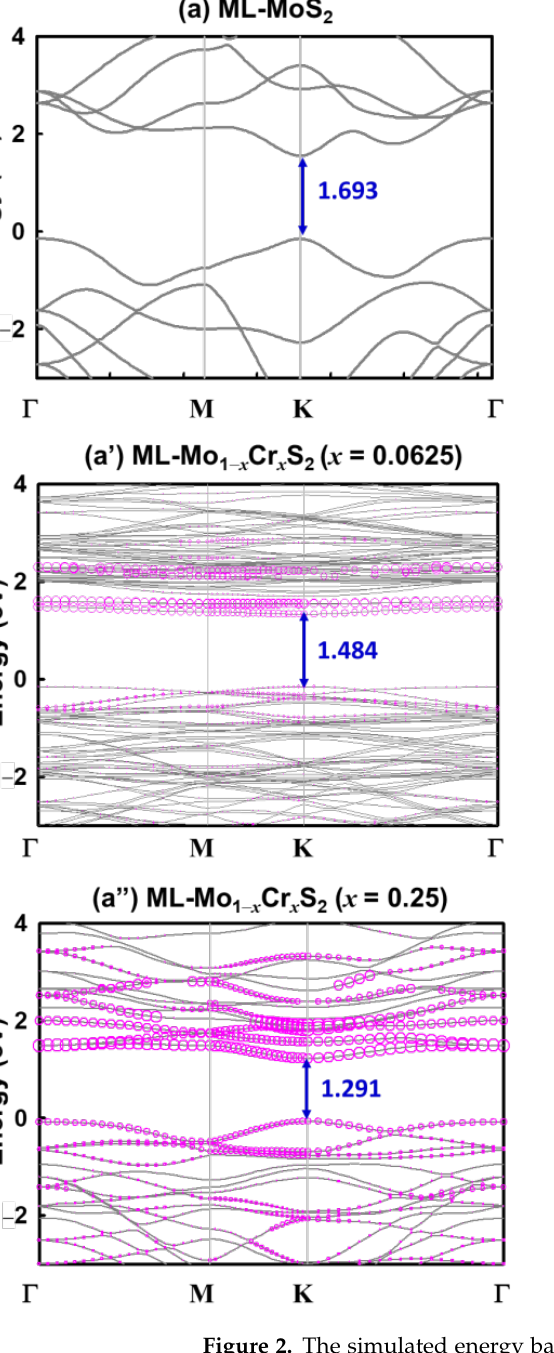
Figure 2. The simulated energy bands of ( a ) ML-MoS 2 and ( b ) ML-WS 2 . ( a (cid:48) , a (cid:48)(cid:48) ) ML-Mo 1 − x Cr x S 2 and ( b (cid:48) , b (cid:48)(cid:48) ) W 1 − x Cr x S 2 materials with respect to different mole fractions. The zero energy was set to the valence band maximum. The black lines and purple circles are all bands and projected bands contributed by the Cr element, respectively. The circle sizes of the projected bands indicate the relative weighting. All of the band structures of ML-Mo 1 − x Cr x S 2 and ML-W 1 − x Cr x S 2 are direct band gap semiconductors.